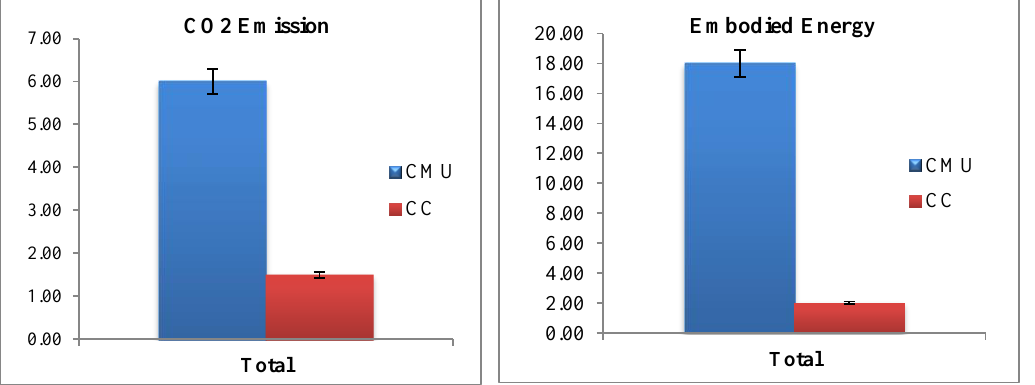
Figure 6. Energy consumption and annual CO2 emission during CMU (Concrete Masonry Unit) Construction and CC (Contour Crafting)